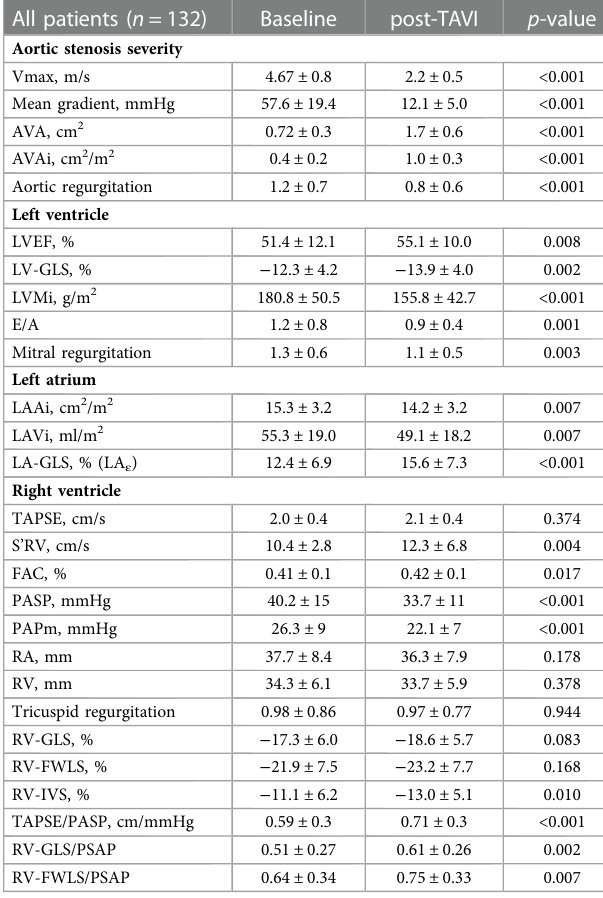
TABLE 3 Echocardiographic changes after TAVI. All patients ( n =